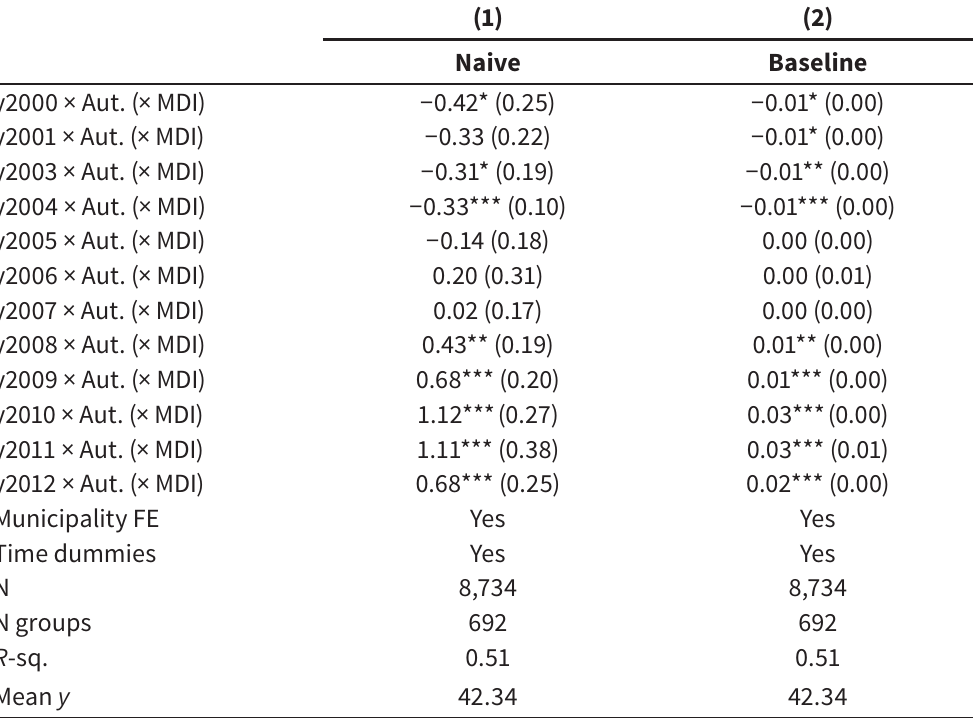
(1) (2) Naive Baseline